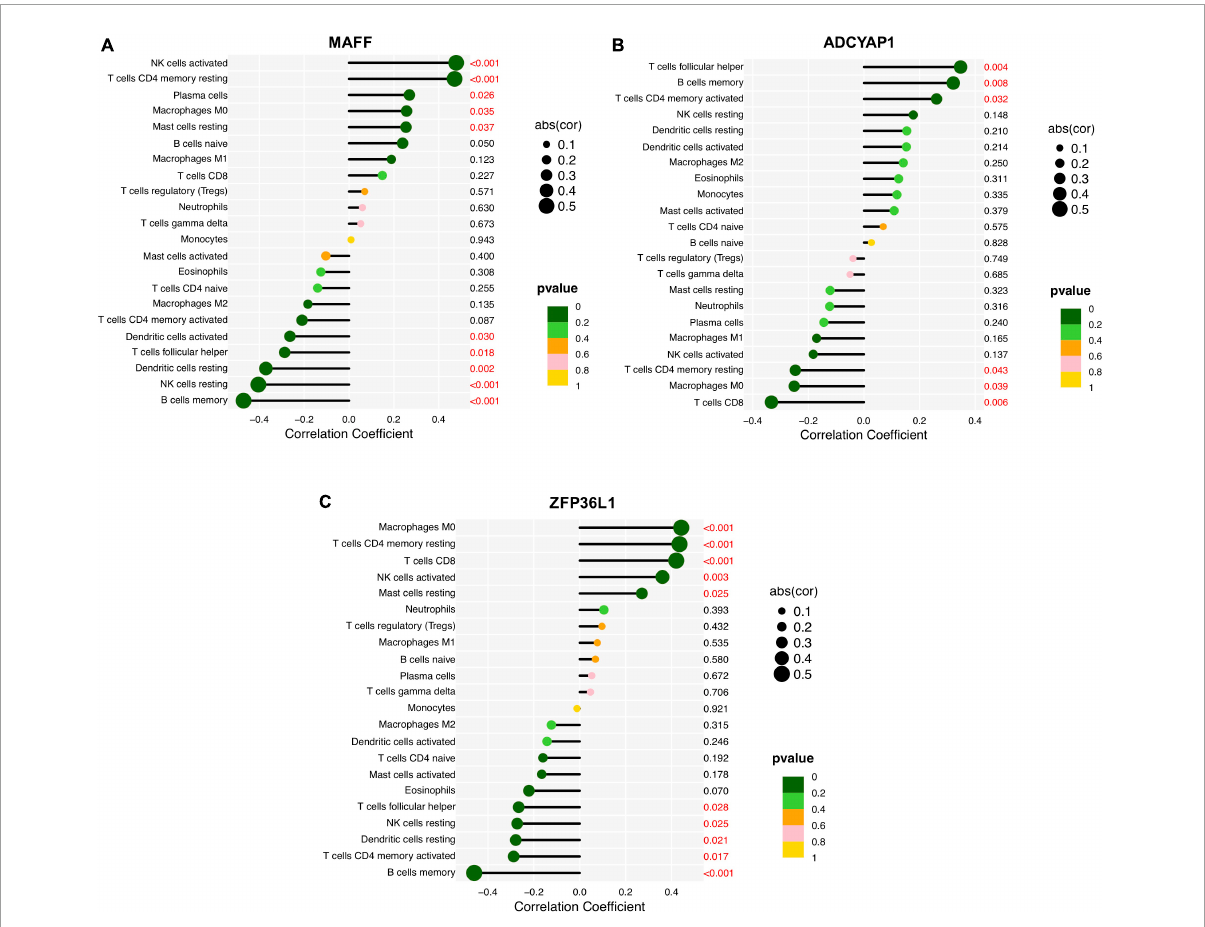
FIGURE8 Correlation analysis between the feature biomarkers and infiltrating immune cells in Alzheimer’s disease (AD). (A) MAFF. (B) ADCYAP1. (C) ZFP36L1.